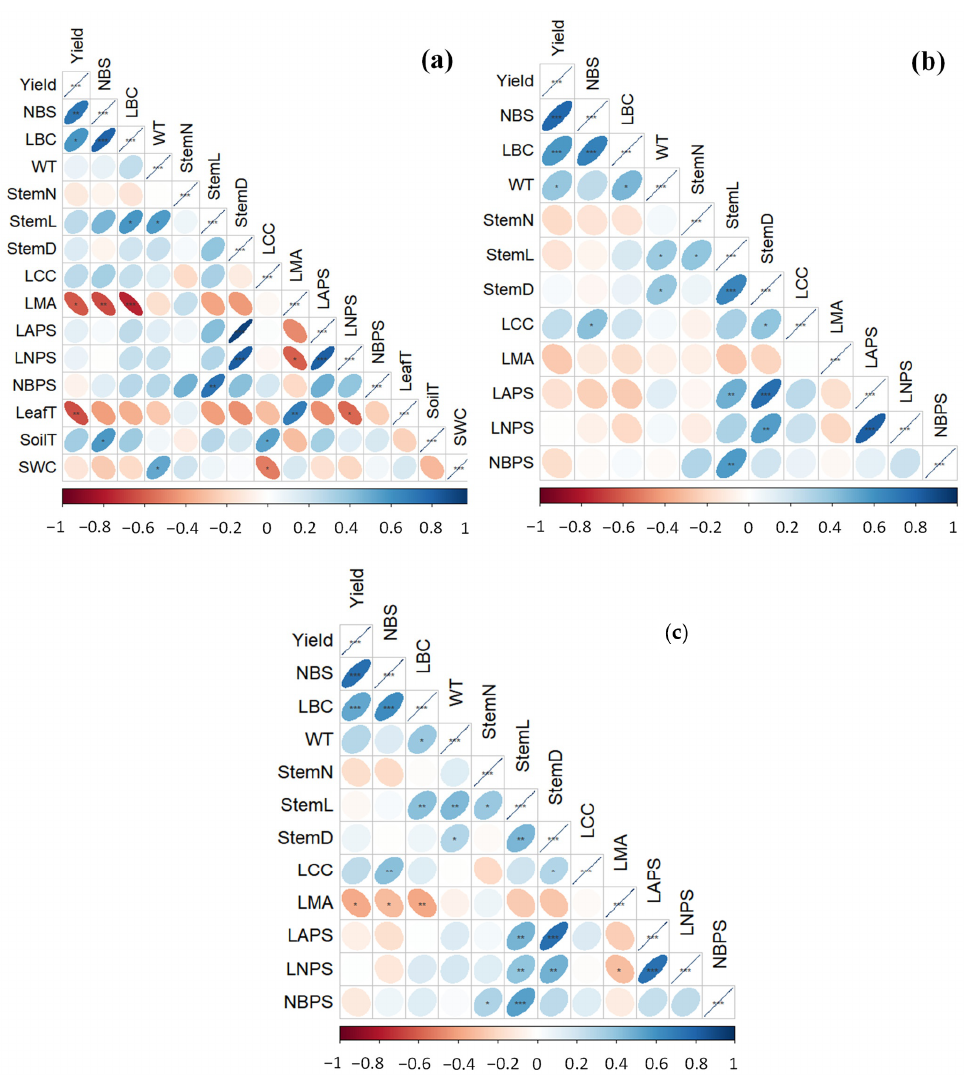
(Figure 4g: R 2 = 0.42, p < 0.01) and quadratic relationships (Figure 4g: R 2 = 0.42, p < 0.05) when we analyzed the relationship between LeafT and Yield (g/m 2 ).